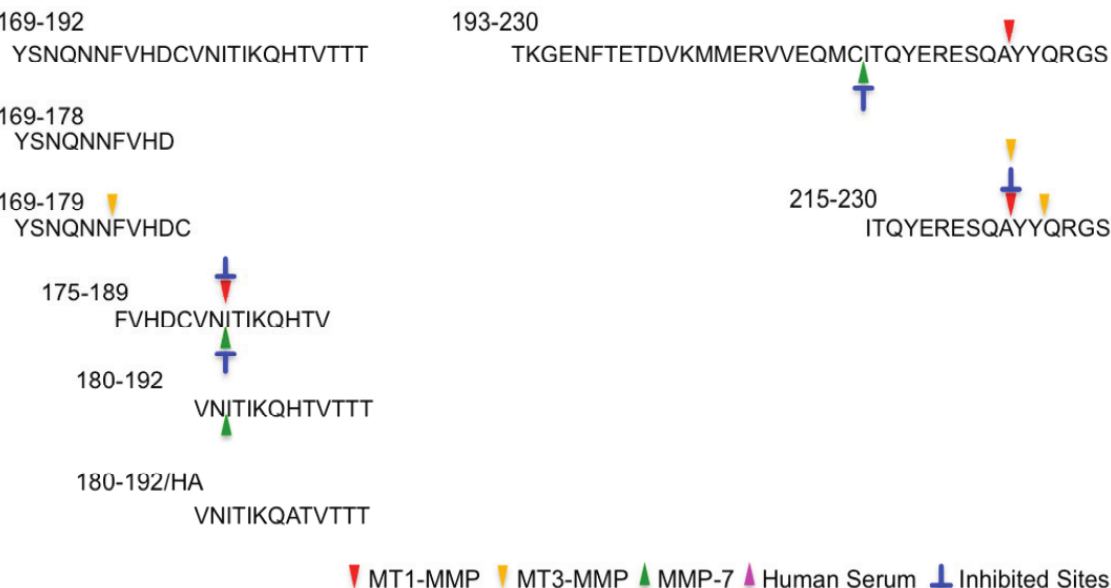
Figure 5. Cleavage sites on the C-terminus region peptides. The cleavage sites are marked with colored triangles: MT1-MMP, red arrow; MT3-MMP, yellow arrow; MMP-7, green arrow; HS, pink arrow and the inhibited sites (blue) are